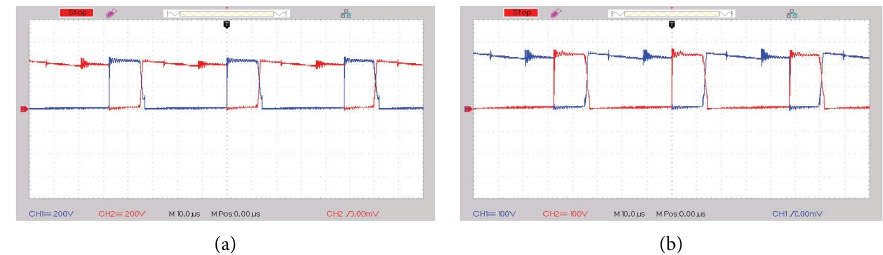
Figure 32: (a) Voltage of S 1 and D 1 . (b) Voltage of S 2 and D 2